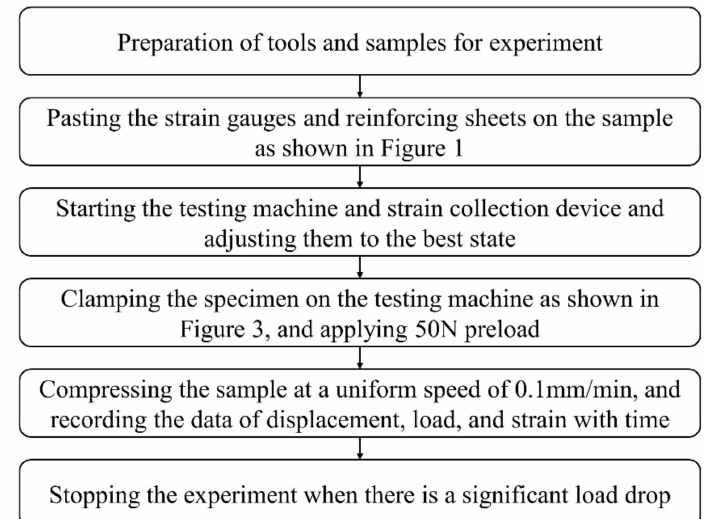
Figure 4. Experimental flowchart.